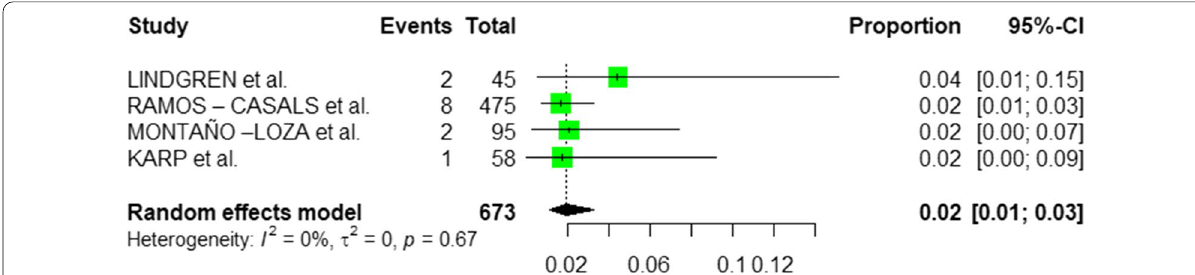
Fig. 1 Meta‑analysis of the AIH prevalence in Sjögren syndrome